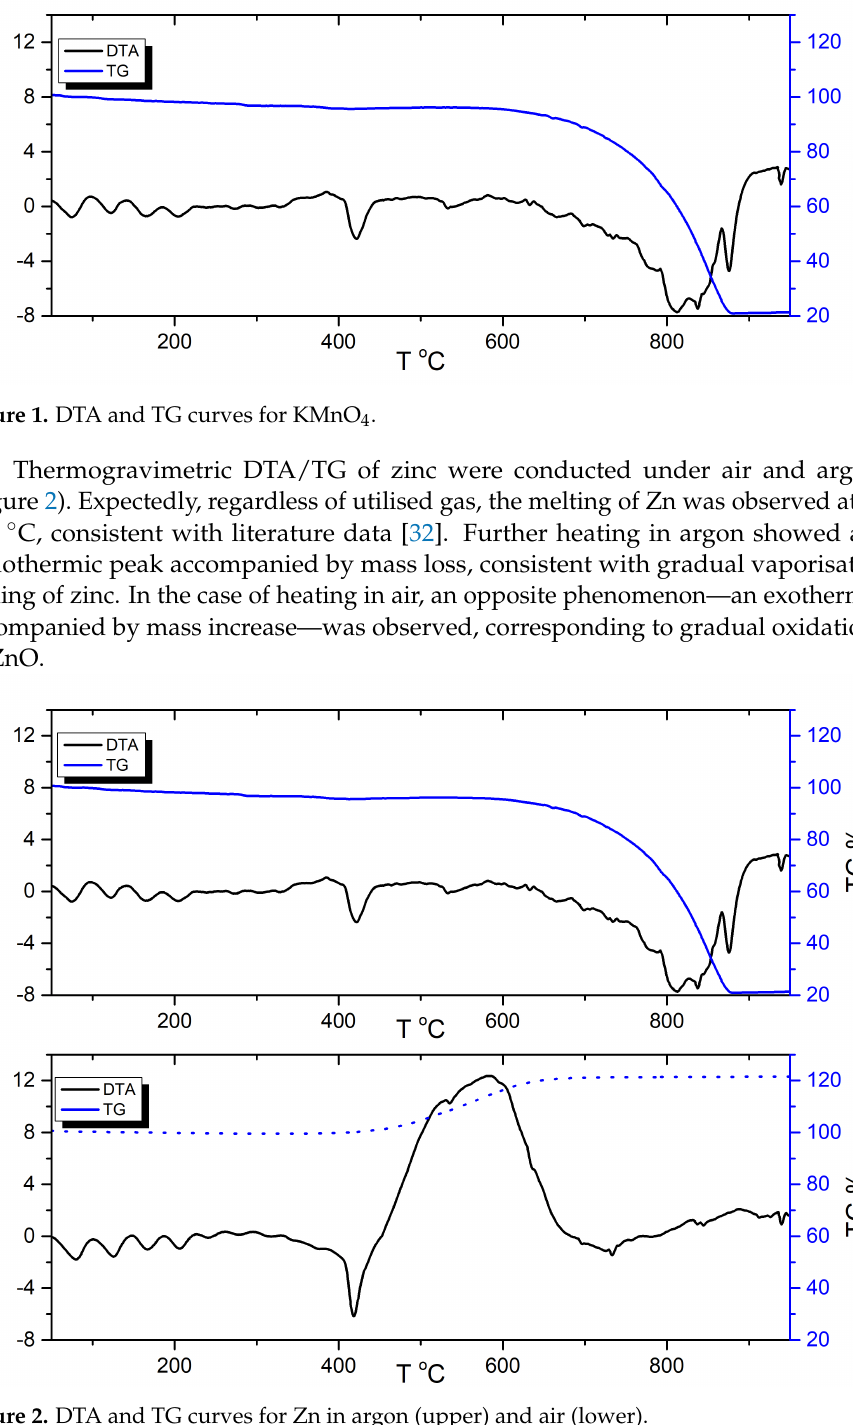
Figure 2. DTA and TG curves for Zn in argon (upper) and air (lower). DTA/TG measurements conducted for the Zn/KMnO 4 PDC formulations (Figure A8) revealed a visible effect of fuel (Zn) content on the thermal behaviour of the PDC formula- tions. For each DTA/TG plot, the first stage of permanganate decomposition is observed in the initial stage (approximately 270–300 ◦ C) of the experiment. This is accompanied by a mass loss, due to KMnO 4 reduction to K 2 MnO 4 [33]. The loss of sample mass is consistent with the calculated value, indicating that the oxygen released at this stage does not undergo a reaction with zinc. This is both due to the inability of oxygen to infiltrate